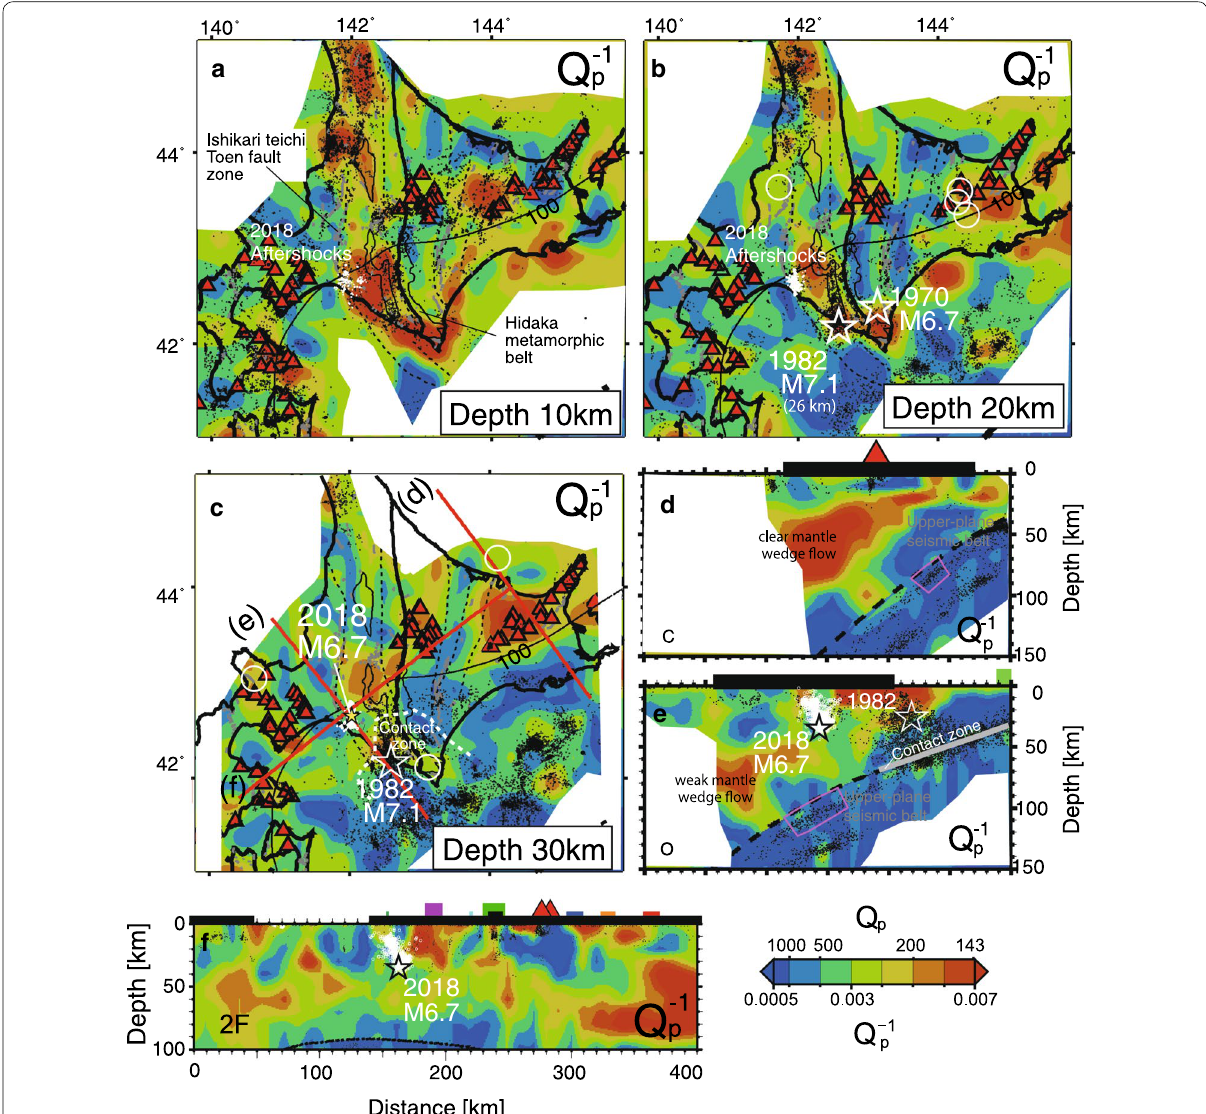
Fig. 6 Relocated hypocenters in the present study plotted on the horizontal cross-sections of seismic attenuation structure (Qp-1) of Kita et al. (2014) shown by the color scale at the bottom at depths of a 10 km, b 20 km, and c 30 km. White dots indicate the hypocenters of aftershocks within 2.5 km in the depth direction, and the yellow star in c indicates the mainshock. White stars indicate the hypocenters of the 1982 and 1970 events. Large circles indicate damaging inland type earthquakes (M5.0–6.5) by Utsu (1999) and Kita et al. (2014). The dashed black lines indicate the locations of tectonic lines. Areas enclosed by black lines indicate the locations of the metamorphic belts. The black curved thick lines and the black vertical line show the costal lines and the boundary of the northeastern and Kuril arc, respectively. Red triangles and the thin black curved line show, respectively, Quaternary volcanoes and the 100-km-depth contour of the subducting Pacific Plate by Kita et al. (2010). The black thick dashed line at the south-central Hokkaido in c shows the contact zone of the forearc crustal materials with the upper interface of the Pacific Plate (Kita et al. 2010). Black dots and gray thin lines show hypocenters of the JMA catalog from 2003 to 2012 and active faults, respectively. White-shaded areas show the areas in which hit count is < 80. d – f Vertical cross-sections of Qp-1 along the three profiles shown in c . The horizontal bold black lines at the top of each plot represent the land area. The dashed black line delineates the upper surface of the subducting Pacific slab. The pink squares and gray line on the dashed black line indicate the locations of the upper-plane seismic belt in the slab crust and the contact zone of the slab upper surface (Kita et al. 2010) with the anomalously deepened crustal materials, respectively. Black and white stars, respectively, show the 2018 Eastern Iburi and 1982 Urakawa-oki earthquakes. White dots represent aftershocks of the 2018 Eastern Iburi earthquake within 5 km of each profile. Black dots represent ordinary earthquakes that occurred within 10 km of each profile. Red triangles represent active volcanoes and Quaternary volcanoes. White-shaded areas show the areas in which the hit count is <